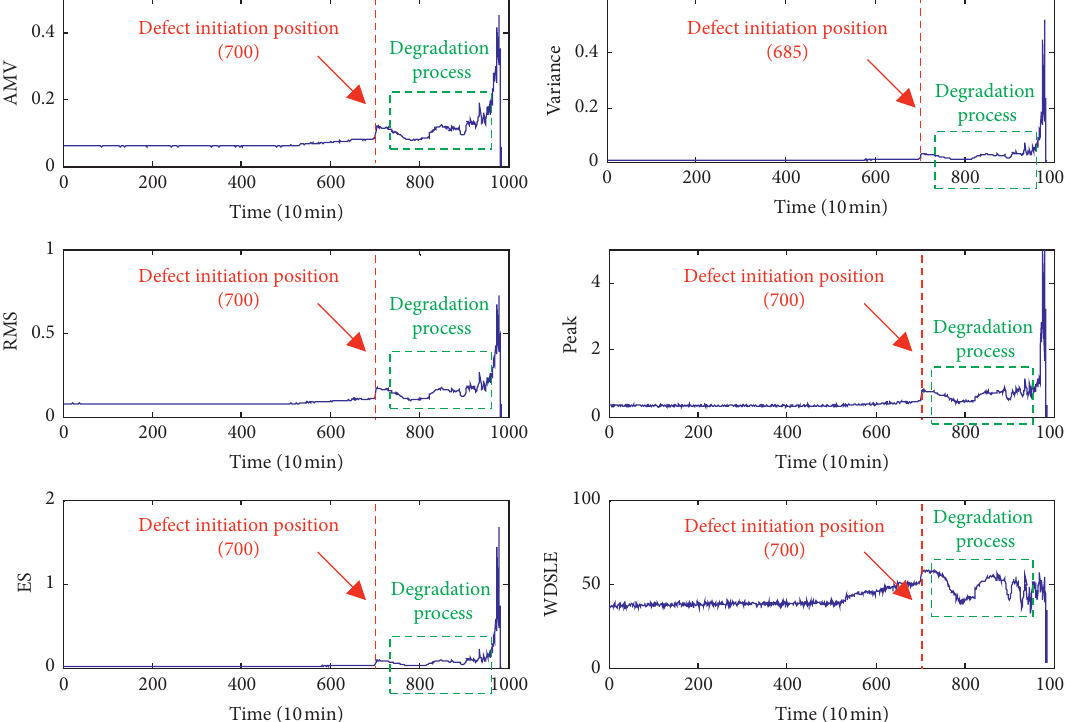
Figure 8: Six characteristic parameters selected by monotonic evaluation